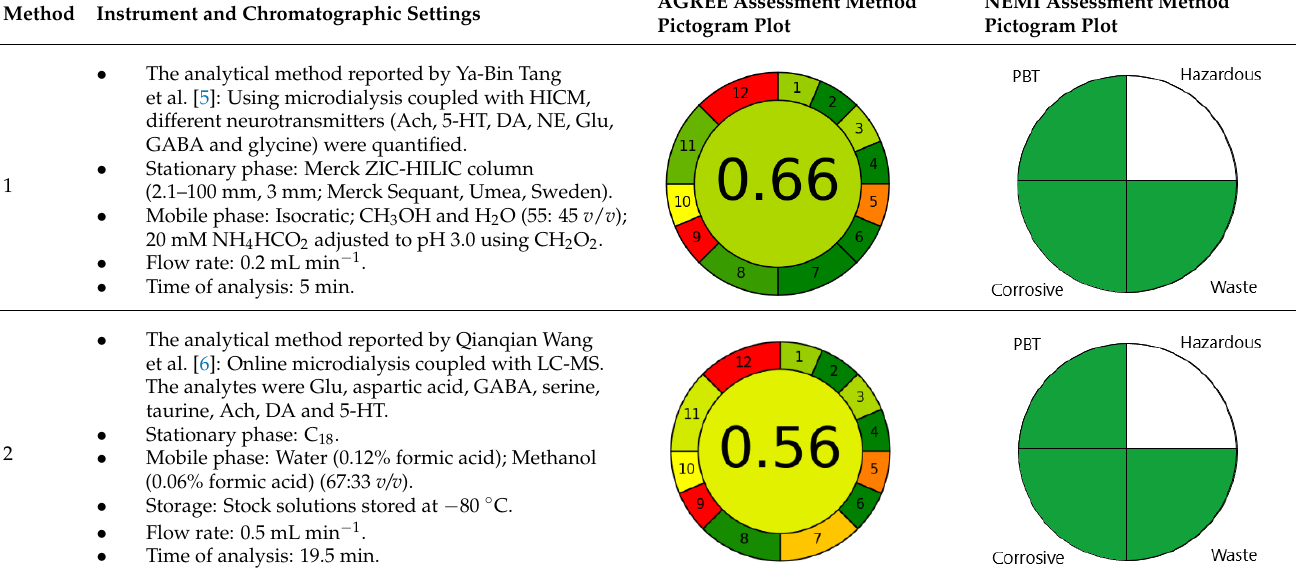
Table 1. Pictogram plots for the AGREE tool for the assessment of the chromatographic methods under comparison.